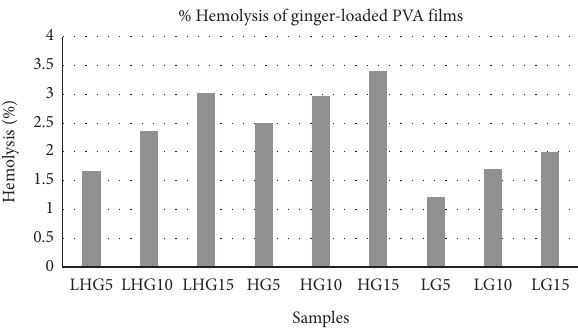
Figure 21: Hemolysis release % of ginger-loaded PVA